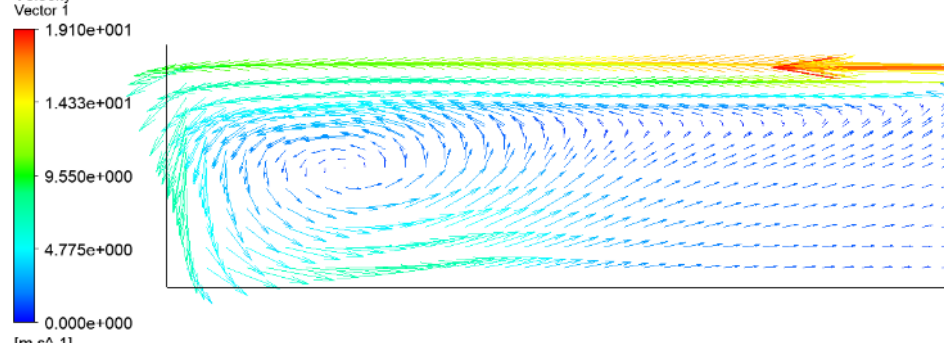
Figure 5. Flow field of combination with A4B1C4.